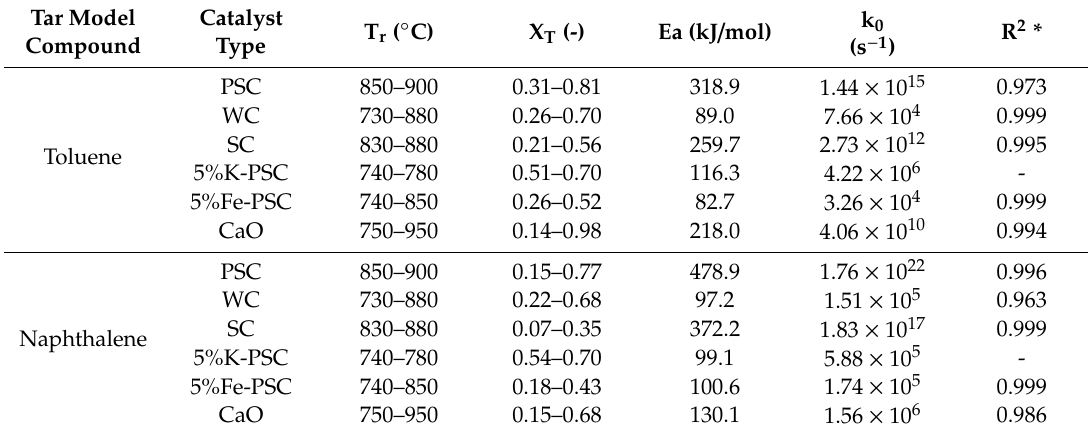
Table 4. E ff ect of temperature on fractional conversions and first-order rate constants for tar reforming over di ff erent catalysts. Calculation by toluene conversions and naphthalene